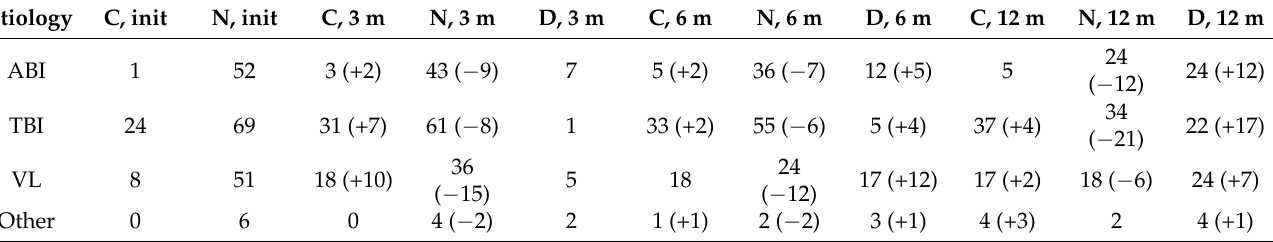
Table 7. The number and growth in communicating, non-communicating, and deceased patients of various etiologies. Etiology C,